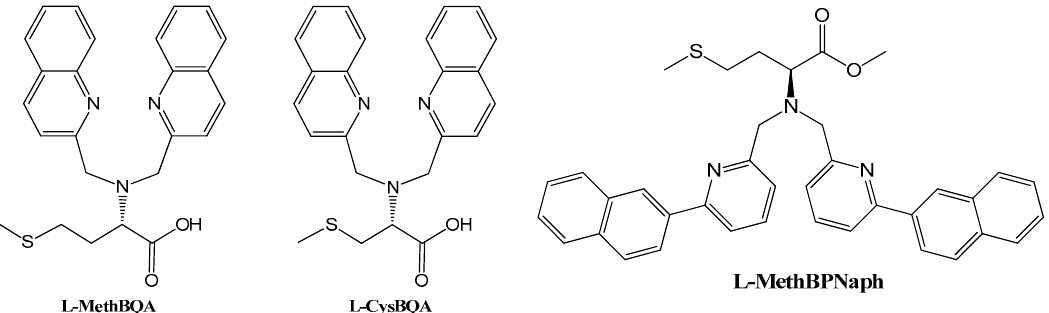
Figure 20. Structures of L -MethBQA, L -CysBQA and a recently synthesized analog L -MethBPNaph.